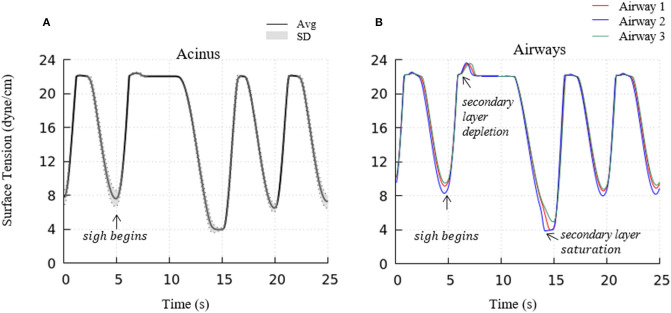
Acinar (A) and representative airways, (B) surface tension after a deep sigh. The secondary layer respreading stabilizes the surface tension around γ∞. In airways, secondary layer depletion can be seen where the surface tension rises rapidly again after being stabilized around γ∞ for a short period. Compared to the stationary tidal breathing state, the additional surfactant in the primary layer by respreading from the secondary layer and adsorption from the bulk during sigh leads to a lower surface tension at end-expiration. The representative airways are the same as those shown in Figure 9.